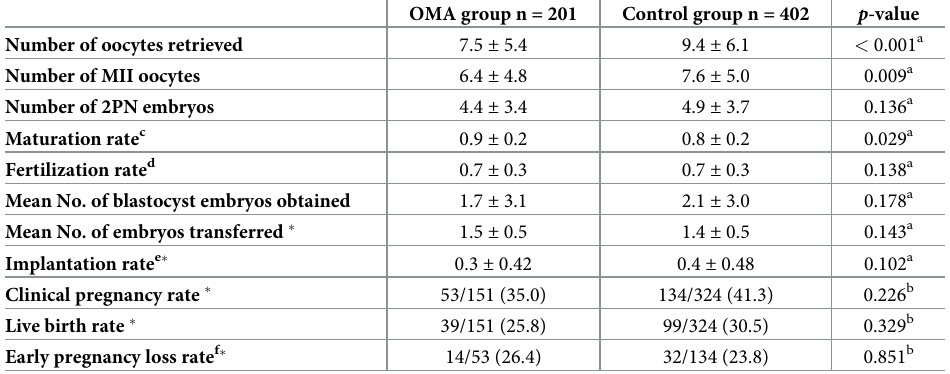
Table 2. Ovarian stimulation characteristics and ART outcomes after the first ET for the OMA group and the control group. OMA group n = 201 Control group n = 402 p -value Number of oocytes retrieved 7.5 ± 5.4 9.4 ± 6.1 < 0.001 a Number of MII oocytes 6.4 ± 4.8 Number of 2PN embryos Maturation rate c 0.9 ± 0.2 0.8 ± 0.2 0.029 a Fertilization rate d 0.7 ± 0.3 0.7 ± 0.3 0.138 a Mean No. of blastocyst embryos obtained 1.7 ± 3.1 2.1 ± 3.0 0.178 a Mean No. of embryos transferred (cid:3) 1.5 ± 0.5 1.4 ± 0.5 0.143 a Implantation rate e (cid:3) 0.3 ± 0.42 0.4 ± 0.48 0.102 a Clinical pregnancy rate (cid:3) 53/151 (35.0) 134/324 (41.3) 0.226 b Live birth rate (cid:3) 39/151 (25.8) 99/324 (30.5) 0.329 b Early pregnancy loss rate f (cid:3) 14/53 (26.4) 32/134 (23.8) 0.851